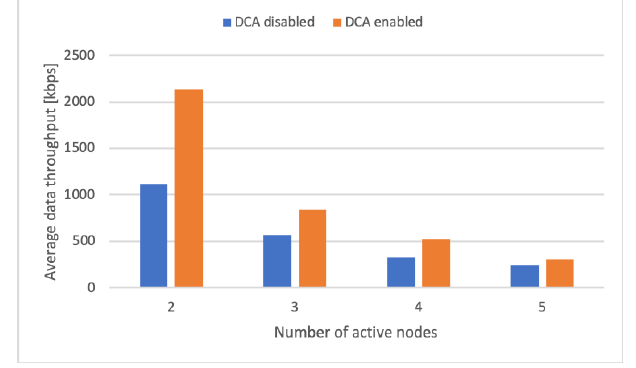
Figure 1 . 5MHz ANW2C End-to-end average data throughput